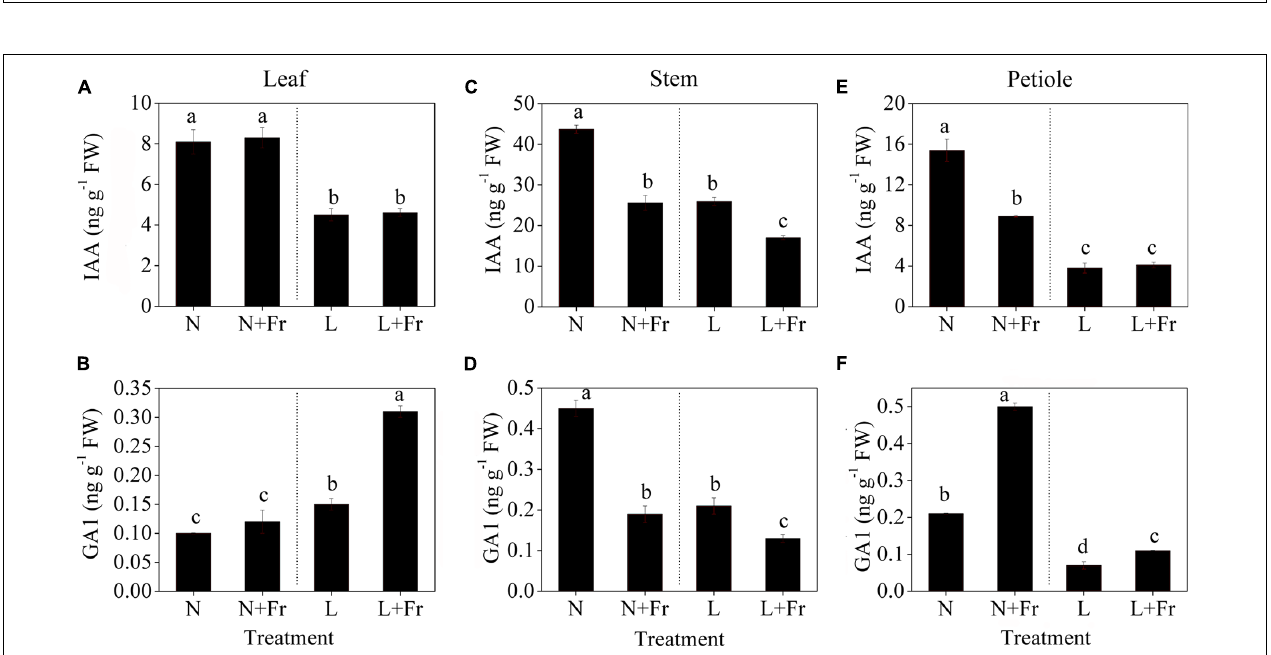
FIGURE 5 | Auxin (IAA) and gibberellin 1 (GA1) levels in different tissues [leaf (A,B) , stem (C,D) , and petiole (E,F) ] of soybean seedlings harvested after 15 days under different light intensity and quality treatments. The leaves and petioles were obtained from the second trifoliolate leaves, and the stem samples were collected from the top internodes. N, N+Fr, L, and L+Fr denote normal light (normal PAR and normal R/Fr ratio), normal light plus far-red light (normal PAR and low R/Fr ratio), low light (low PAR and normal R/Fr ratio), and low light plus far-red light (low PAR and low R/Fr ratio), respectively. Each value is expressed as the mean ± SE. The means for each treatment that do not have a common letter are significantly different at P = 0.05, according to Duncan’s multiple range test.